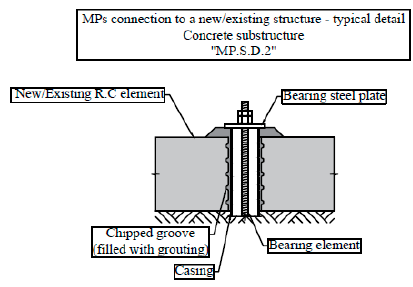
Figure 11. MP connection to a new structure (new reinforced concrete footing)—typical detail (after [1]).